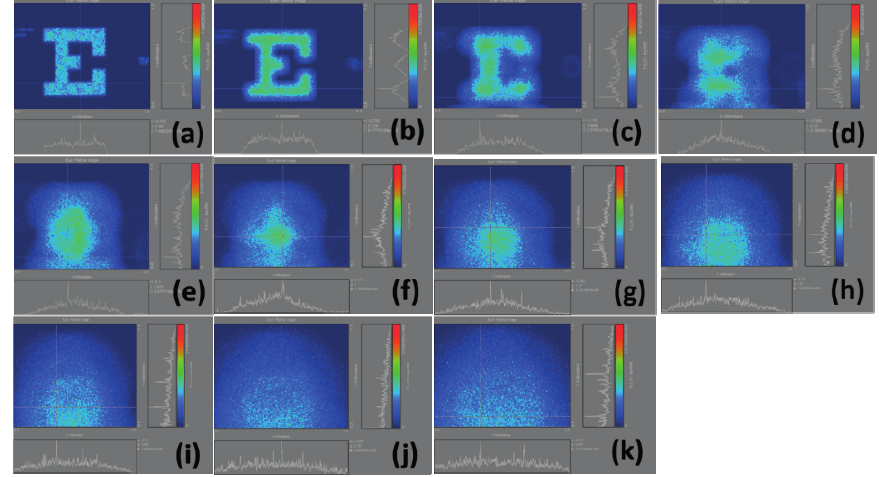
Figure 5. Calculation results of retinal images by selecting the whole Snellen chart in Figure 3(b); ( a ) plano; ( b ) 1.00 D; ( c ) 2.00 D; ( d ) 3.00 D; ( e ) 4.00 D; ( f ) 5.00 D; ( g ) 6.00 D; ( h ) 7.00 D; ( i ) 8.00 D; ( j ) 9.00 D; ( k ) 10.00